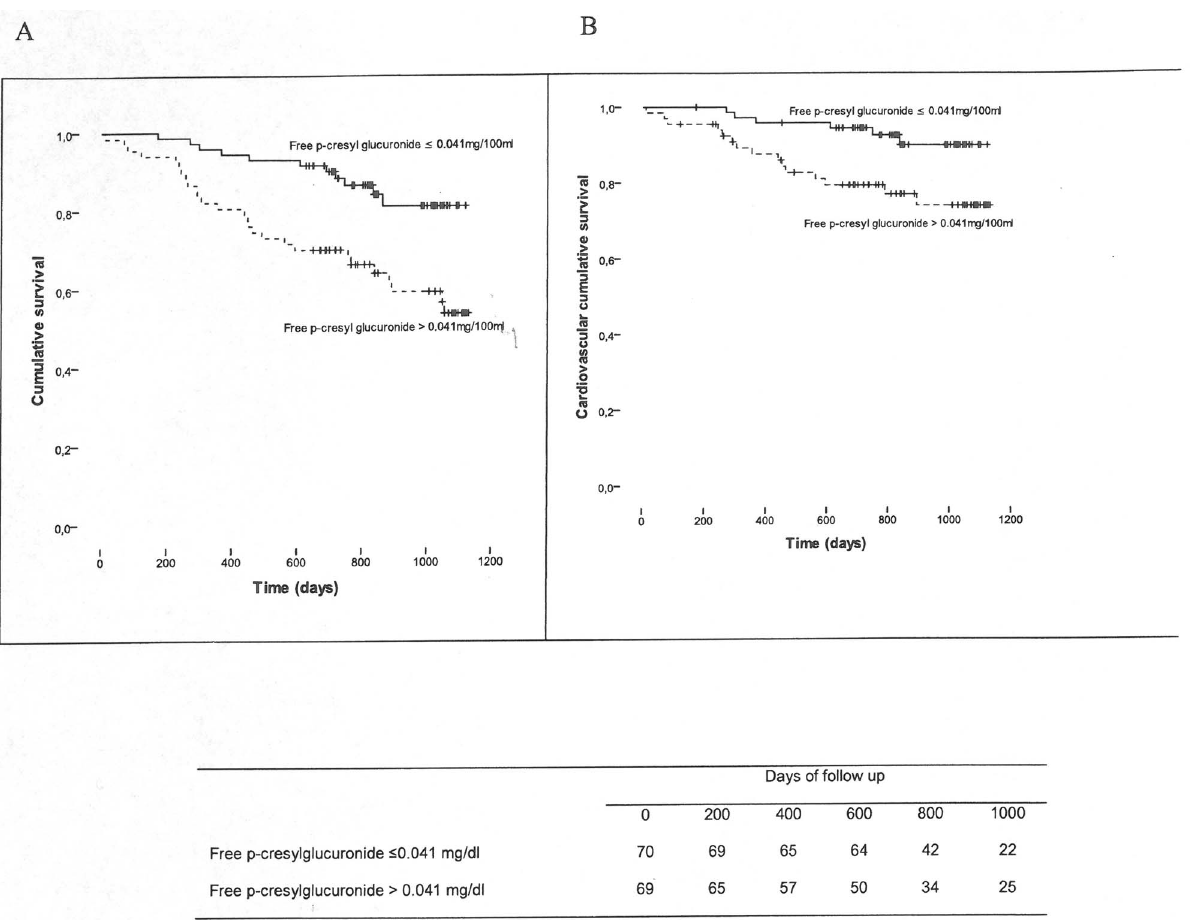
Figure 4. Mortality and free p-cresylglucuronide levels (A) Kaplan–Meier estimates of overall mortality as a function of free p- cresylglucuronide levels relative to the median; p=0.002 in a log-rank comparison of the curves. (B) Kaplan–Meier estimates of cardiovascular mortality as a function of free p-cresylglucuronide levels relative to the median; p=0.01 in a log-rank comparison of the curves.